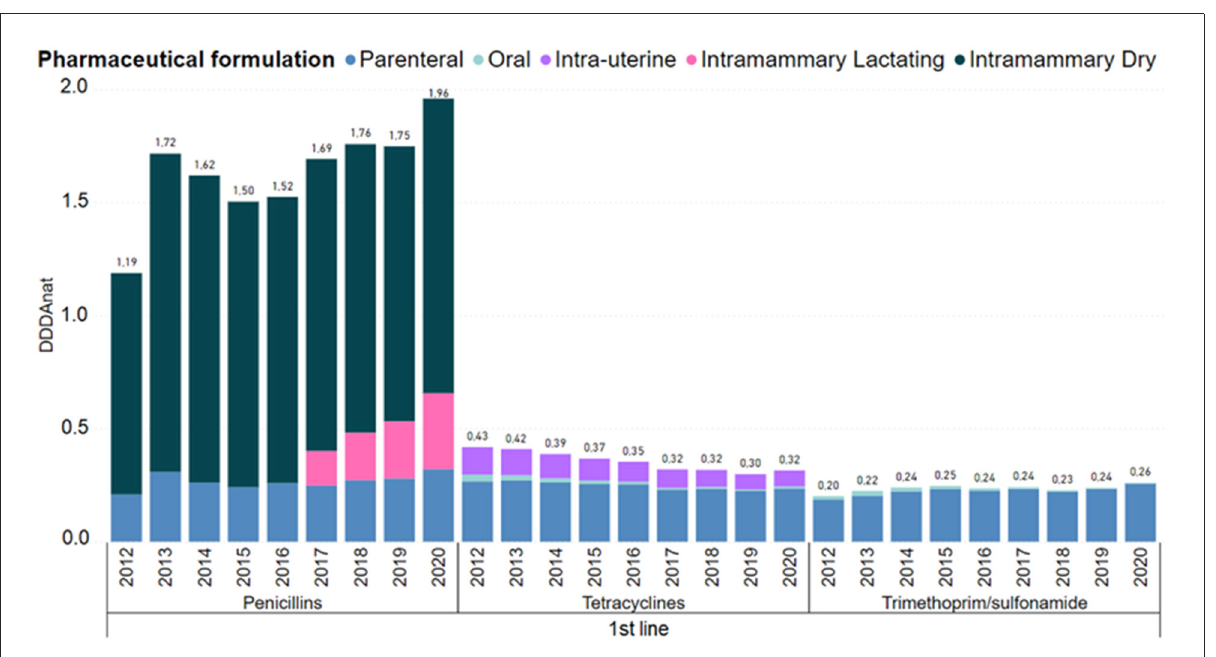
FIGURE4 Antimicrobial consumption in the Dutch dairy sector of 1st line products, in DDDANAT units, from 2012 to 2020, segmented into the different pharmaceutical formulation. Amphenicols, macrolides/lincosamides were left out because each group represented < 5% of the overall use in this line of choice. Full graph can be consulted in the Supplementary